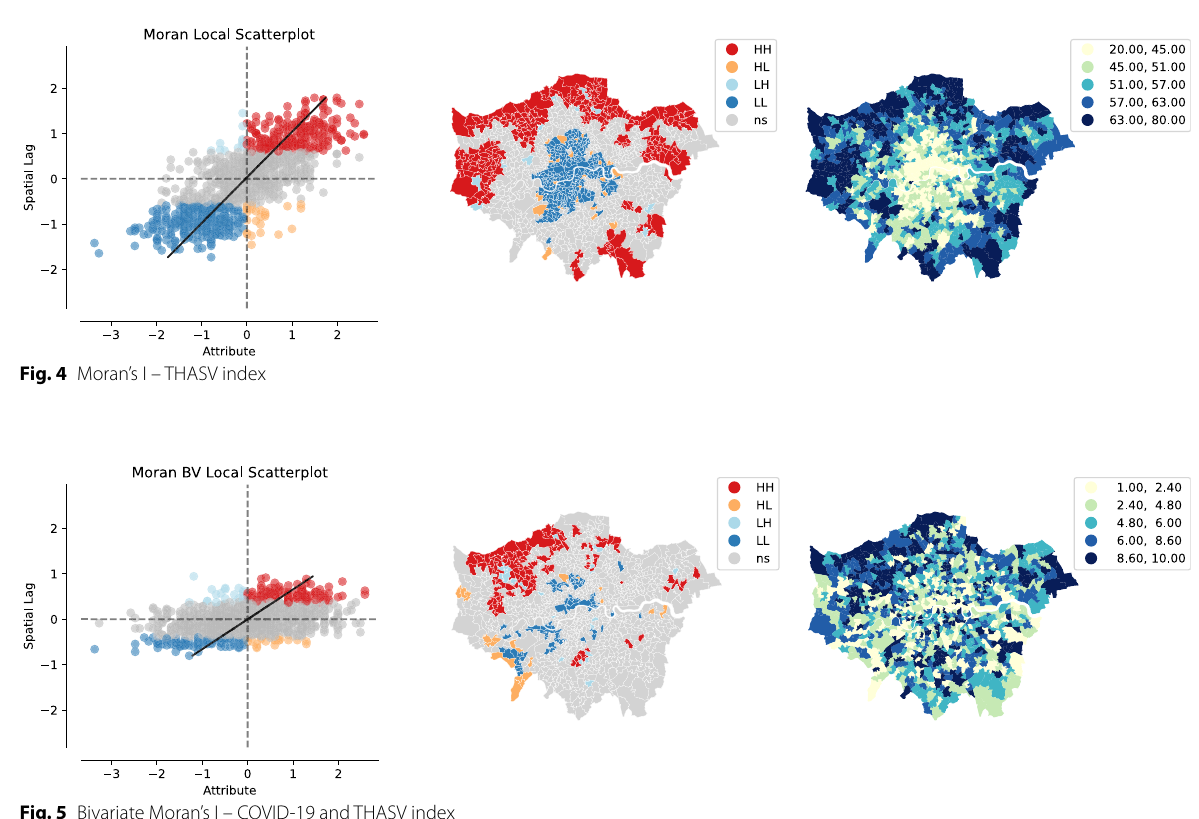
Fig. 5 Bivariate Moran’s I – COVID-19 and THASV